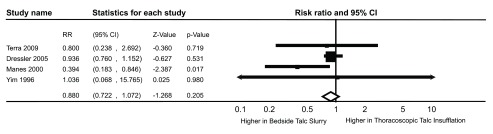
Pooled relative risks (RRs) for non-respiratory complications post talc pleurodesis.
RR,
risk ratio,
CI, confidence interval.